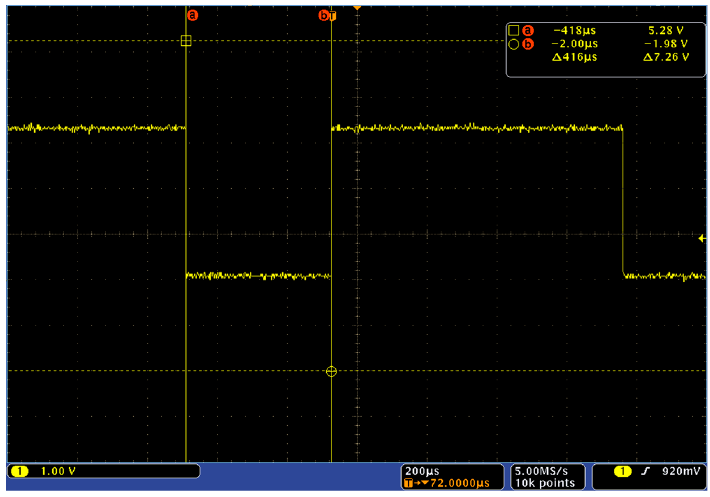
Figure 24. Mean time per bit measurement ( Te ).